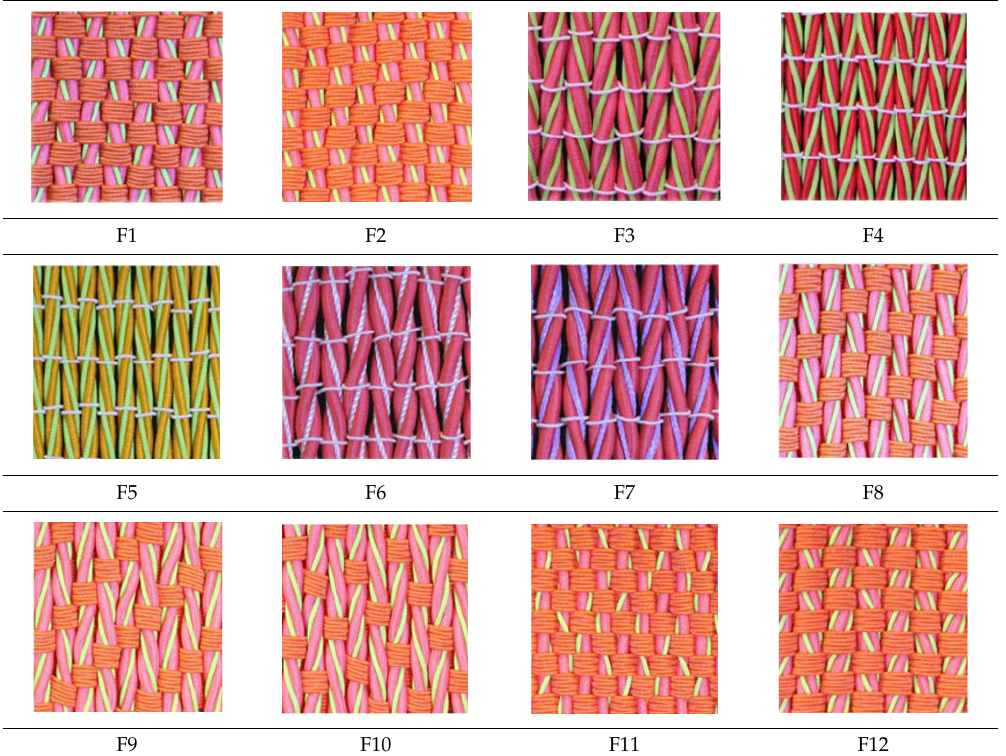
Table 3. Photographs of the woven fabric samples produced.